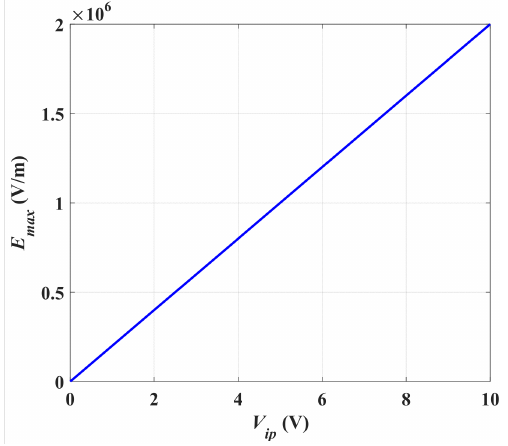
Figure 3. E max between the converter fingers at different V ip